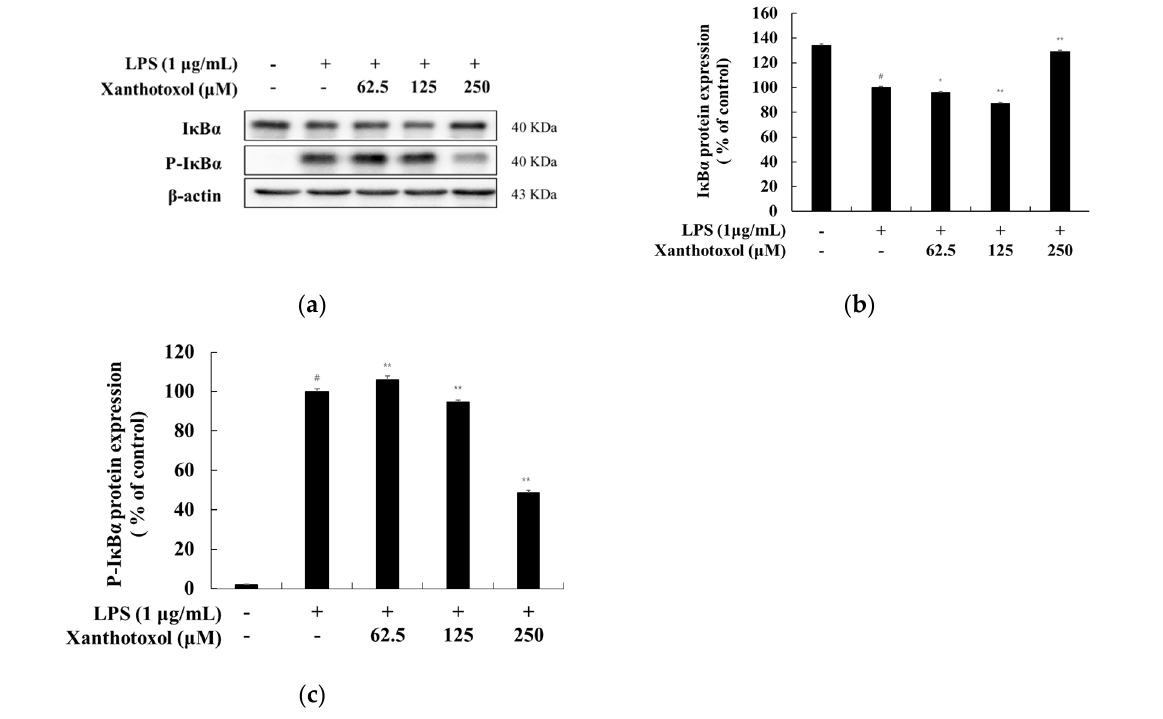
Figure 7. Effect of xanthotoxol on protein expression level of P-I κ B α and I κ B α in LPS-induced RAW 264.7 cells. The cells were treated with xanthotoxol (62.5, 125, and 250 μ M) and LPS (1 μ g/mL) for 20 min. ( a ) Western blotting results, and protein expression of ( b ) I κ B α and ( c ) P-I κ B α . β -actin was used as a loading control. The results are presented as the mean ± SD from three independent measurements using the Image J. # p < 0.01 vs. untreated control group. * p < 0.05 and ** p < 0.01 vs. LPS alone.